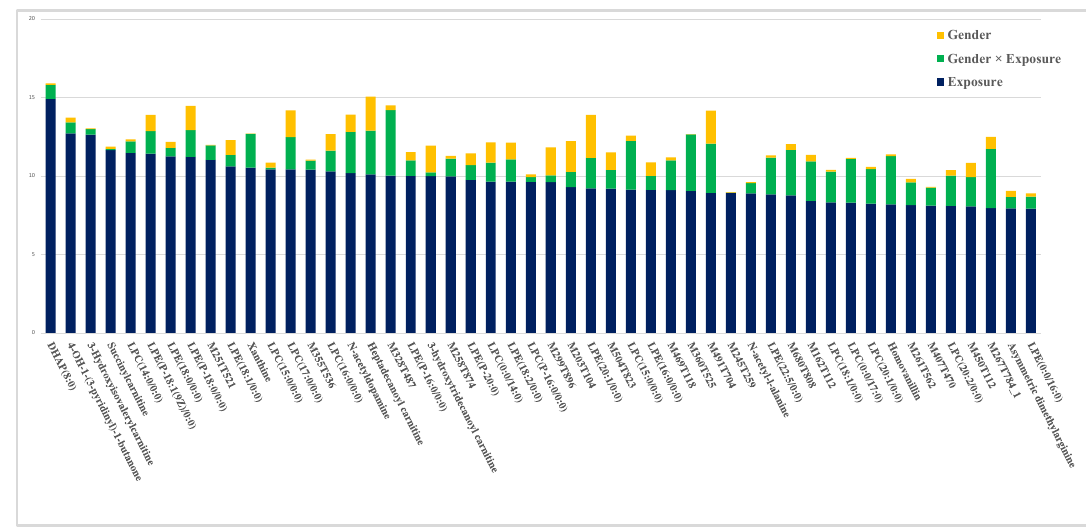
Figure 1. Effect-specific variable importance in the projection (VIP²) values for the 50 highest ranked Figure 1. E ff ect-specific variable importance in the projection (VIP 2 ) values for the 50 highest ranked metabolites according to the impact of the Exposure factor. metabolites according to the impact of the Exposure factor.